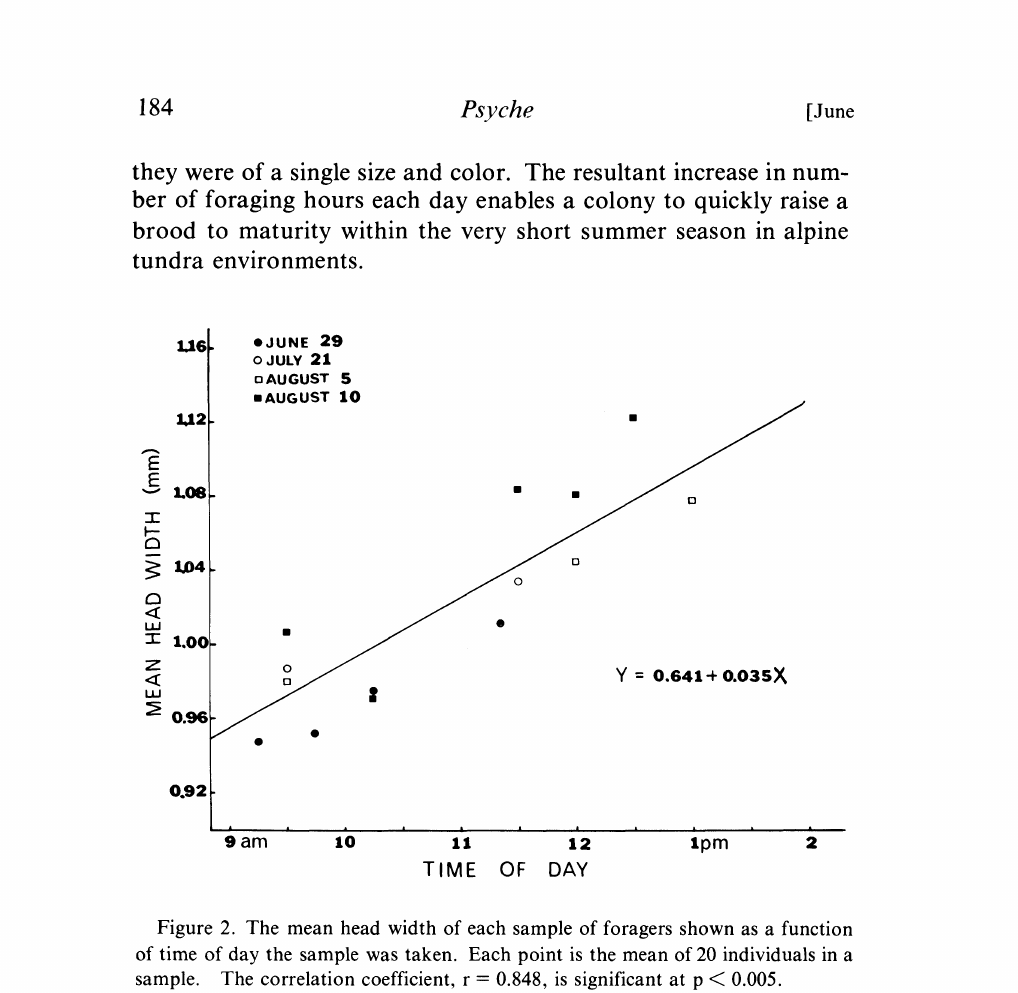
Figure 2. The mean head width of each sample of foragers shown as a function of time of day the sample was taken. Each point is the mean of 20 individuals in a sample. The correlation coefficient, 0.848, is significant at p <